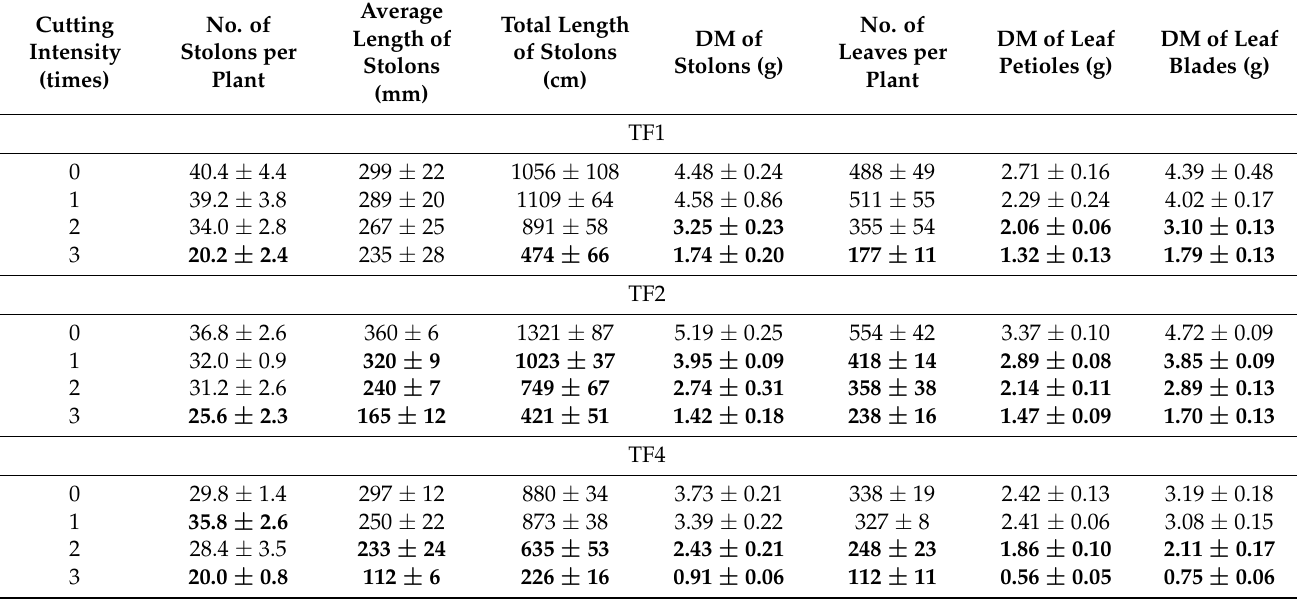
Table 3. Effect of cutting intensity on morphological parameters and dry mass of shoot parts of different Trifolium fragiferum accessions. Cutting